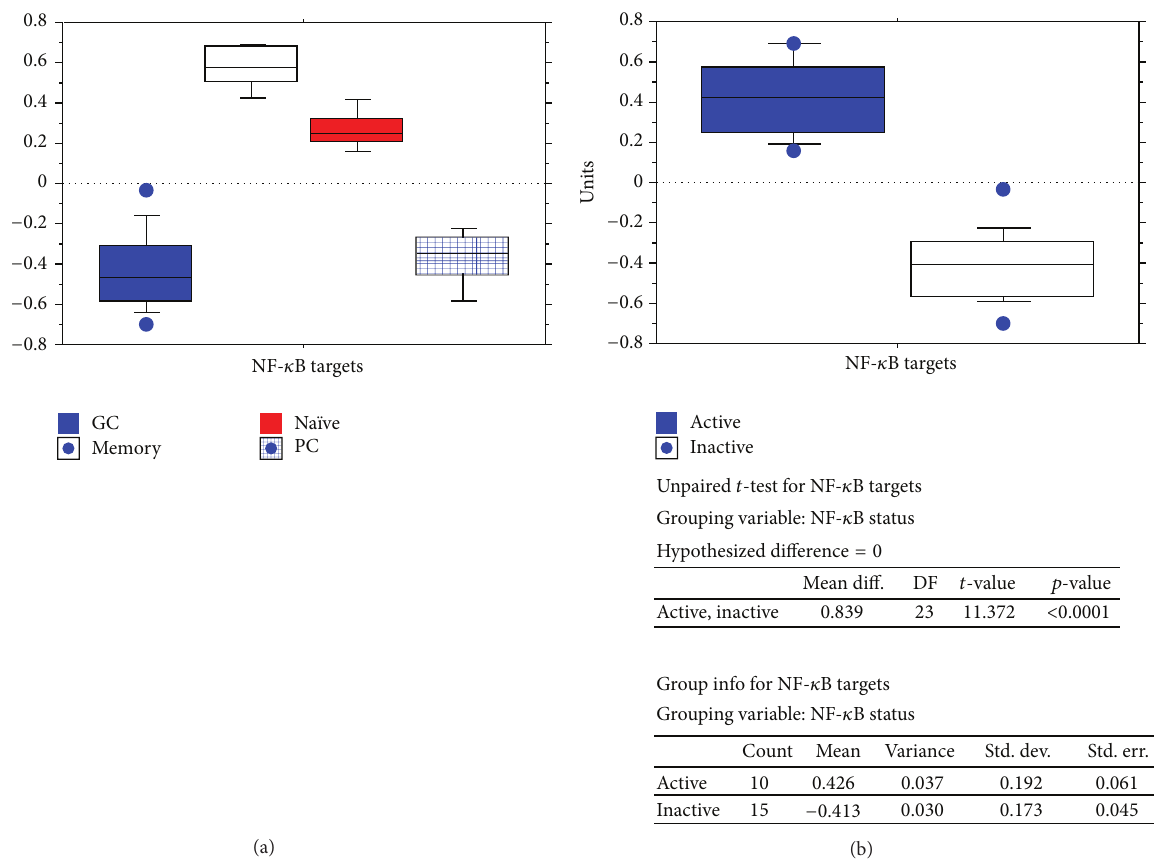
Figure8: Correlationbetween IFI16 andNF- 𝜅 BtargetgeneexpressioninnormalB-cellsubsets.ExpressionofNF- 𝜅 Btargetgeneswasstudied in the different B-cell populations (a). A mean of the normalized expression values of the considered target genes was calculated and defined as the NF- 𝜅 B signature. Cases with NF- 𝜅 B signature values below 0 were considered to have an inactive pathway; cases with values above 0 were considered as having an active pathway. IFI16 mRNA expression levels were then analyzed in the two groups (b). Significantly higher IFI16 mRNA levels were detected in normal samples with an active NF- 𝜅 B signature ( 𝑝 < 0.0001 ). Specifically, germinal center cells and plasma cells (low NF- 𝜅 B signature) were compared to na¨ıve and memory cells (high NF- 𝜅 B